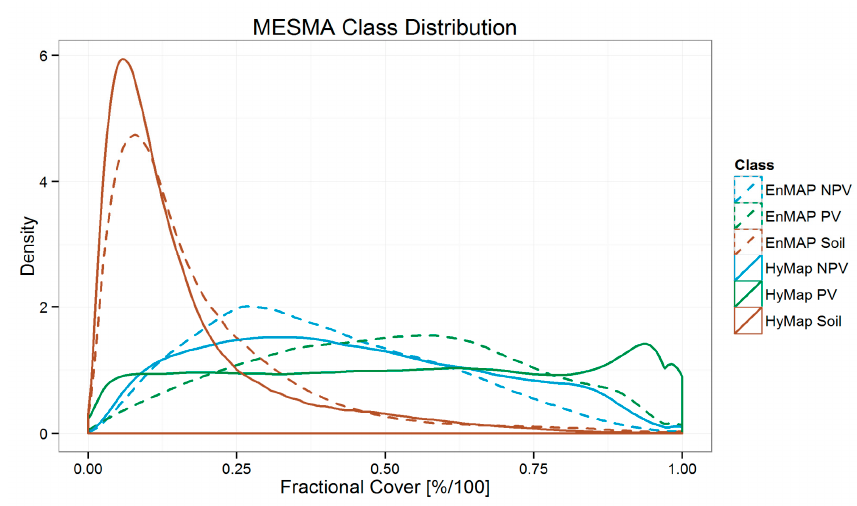
Figure 5. MESMA fractional cover histograms for HyMap (solid lines) and EnMAP (dotted lines) imagery for PV (green), NPV (blue) and BS